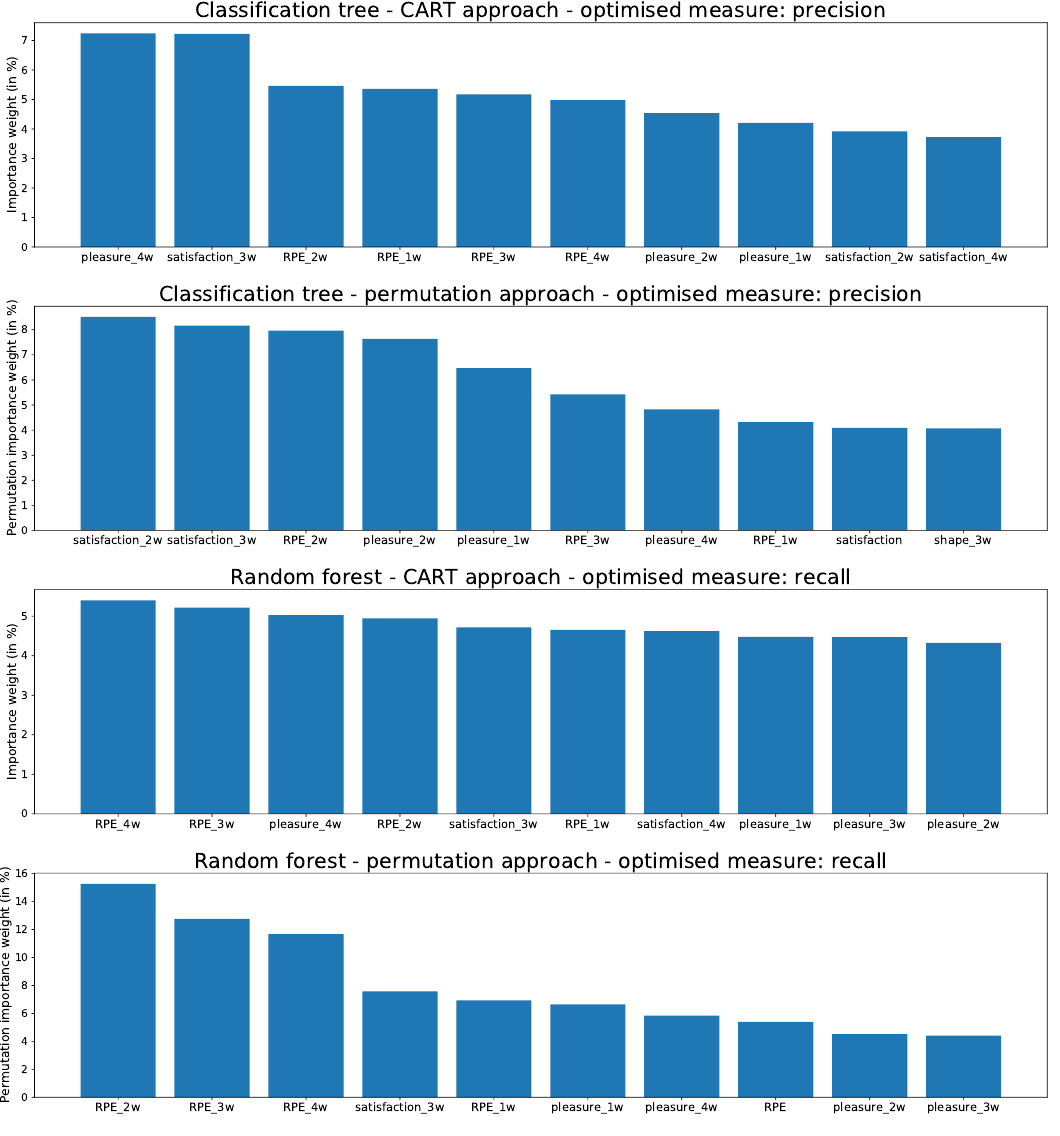
Figure 7. Best features importance for 1-week injury